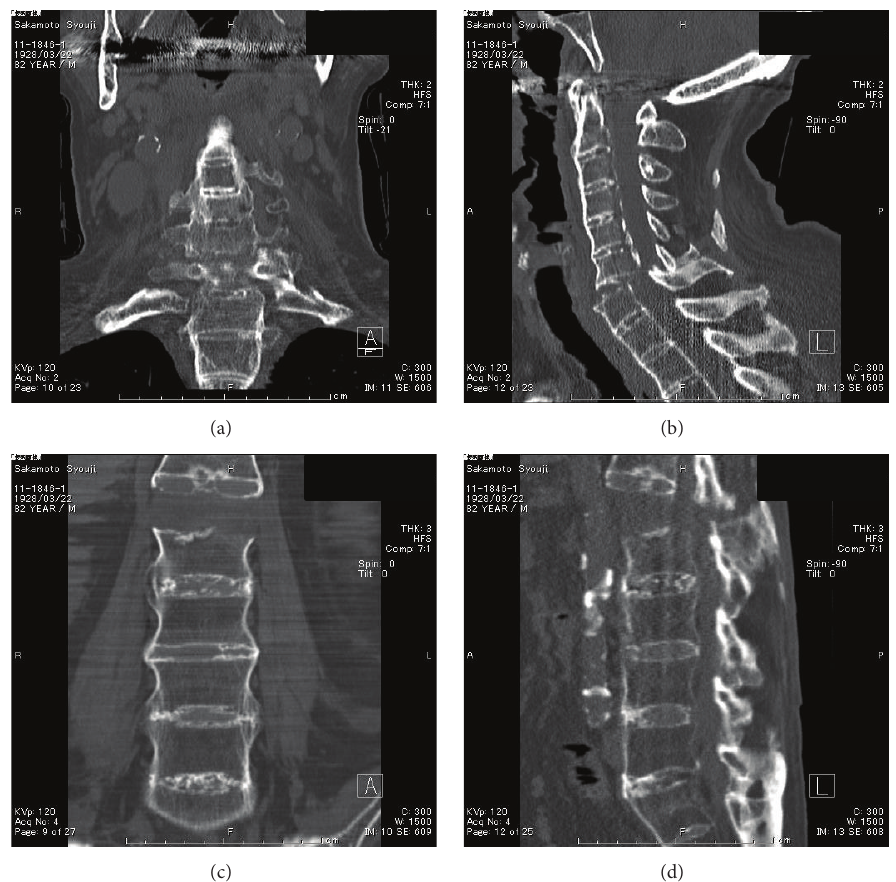
Figure 2: CT scan shows simultaneous cervical and lumbar spine fractures and dislocations at the level of C6-C7 ((a) and (b)) and L1 ((c) and (d)).